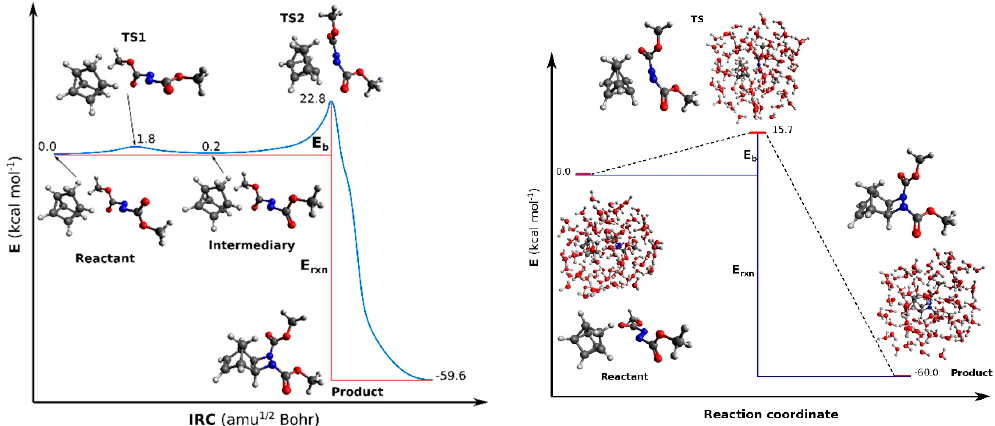
Figure 6. Reaction profile of quadricyclane with dimethyl azodicarboxylate in the gas and liquid phase (respectively, left and right panels).